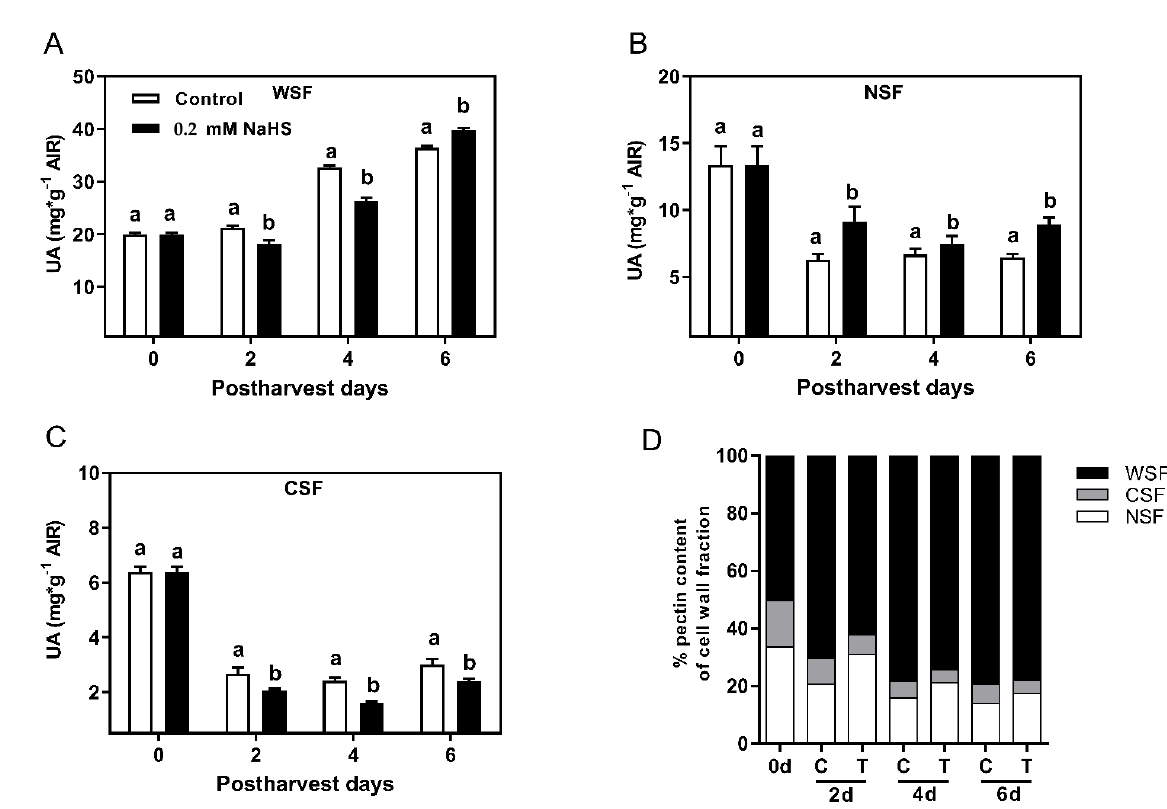
Figure 4. Effects of H 2 S treatment on the content of pectin-related polymers during postharvest shelf-life of Chilean strawberry ( Fragaria chiloensis ) fruit. Strawberries were treated after harvest with 0.2 mM H 2 S donor NaHS, and sampling was performed at harvest (0 d) and after 2, 4 and 6 d of storage at 20 °C. The content of uronic acids (UA) was determined in the water (WSF)-, CDTA (CSF)- and Na 2 CO 3 (NSF)-soluble cell wall fractions. Changes in ( A ) water-soluble pectins; ( B ) CDTA-soluble pectins; ( C ) Na 2 CO 3 -soluble pectins, and ( D ) the relative content (%) of several pectin fractions in control and H 2 S-treated fruits during postharvest. Values correspond to the mean of three independent cell wall extractions per sampling date. Each value is the mean of three replicates and vertical bars represent standard errors. Different lowercase letters indicate significant differences between control and treatment conditions in each day at p < 0.05. For details, see Section 4.